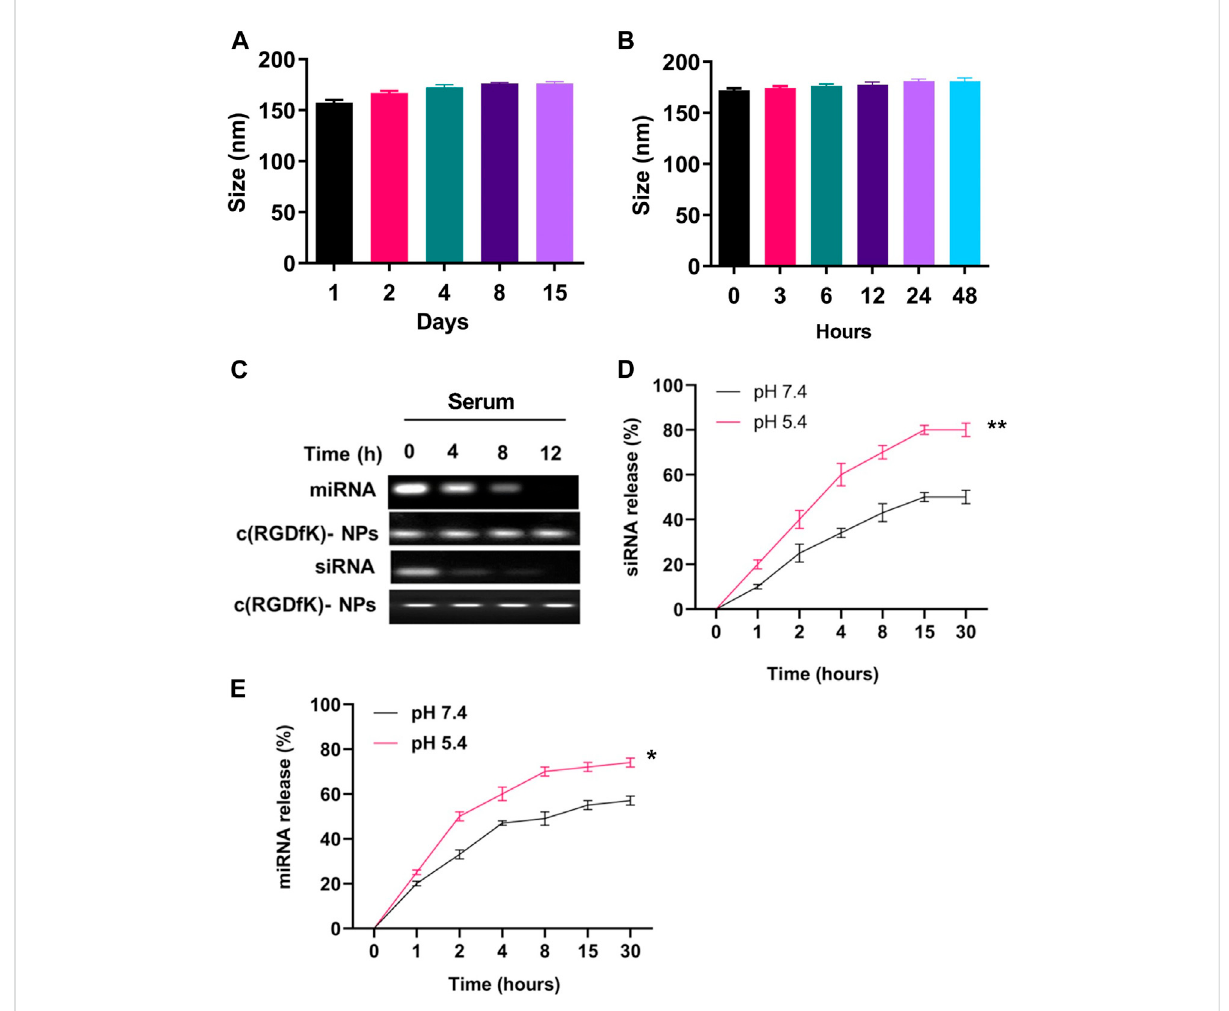
Stability and release study of nano-system. (A) The average size of c(RGDfK)-MSN NPs after incubation with PBS solution for time intervals. (B) The average size of c(RGDfK)-MSN NPs after incubation with 50% serum for time intervals. (C) The ability of c(RGDfK)-MSN NPs to protect miR-34a and siPD-L1 against degradation after incubation with 50% serum for time intervals. (D) In vitro release of siPD-L1 from c(RGDfK)-MSN NPs in different pH values (pH 7.4 and 5.4). (E) In vitro release of miR-34a from c(RGDfK)-MSN NPs in different pH values (pH 7.4 and